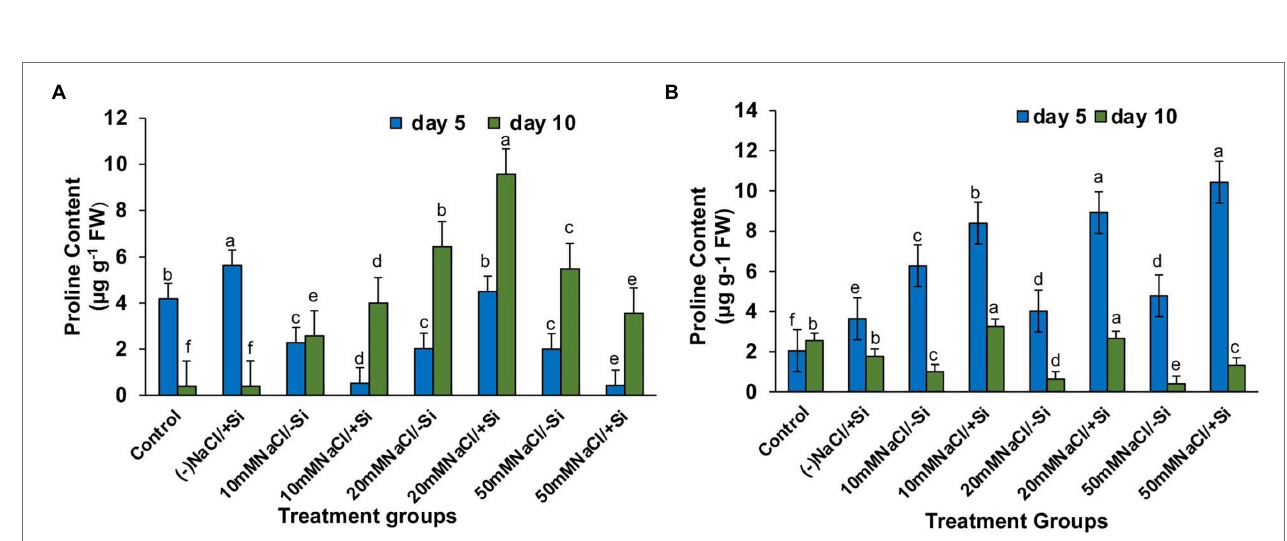
FIGURE 9 | Changes in proline of mung bean ( Vigna radiata ) under (A) 1 mM (Si 1 ), (B) 5 mM (Si 2 ) Si supply and salinity stress after eight treatments: (i) control (T1), (ii) − NaCl+Si (1 mM/5 mM) (T2), (iii) 10 mM NaCl/ − Si (T3), (iv) 10 mM NaCl/+Si (1 mM/5 mM) (T4), (v) 20 mM NaCl/ − Si (T5), (vi) 20 mM NaCl/+Si (1 mM/5 mM) (T6), (vii) 50 mM NaCl/ − Si (T7), and (viii) 50 mM NaCl/+Si (1 mM/5 mM) (T8) for a period of 5 and 10 days. Vertical bars indicate Mean ± SE of the means for n = 4. Means denoted by the different letters are significantly different at p ≤ 0.05 according to the Tukey’s studentized range test.